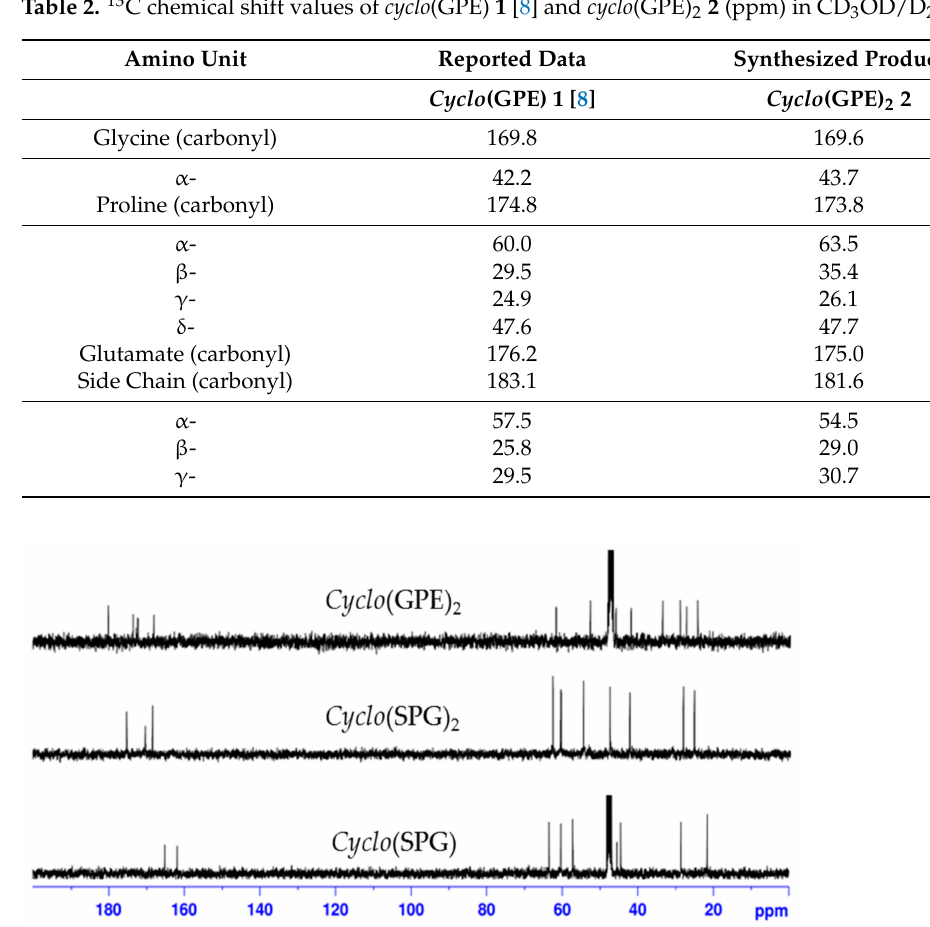
Table 2. 13 C chemical shift values of cyclo (GPE) 1 [8] and cyclo (GPE) 2 2 (ppm) in CD 3 OD/D 2 O.